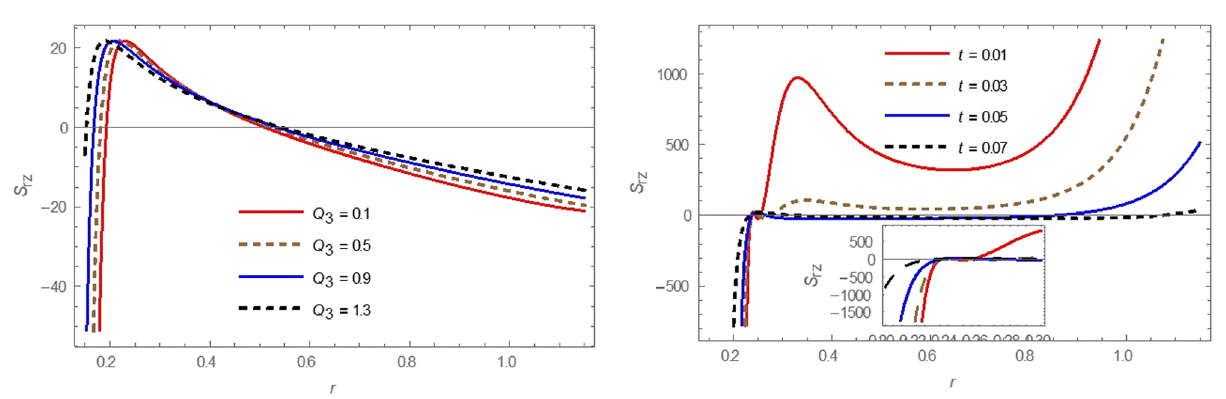
Figure 13: E ff ect of di ff erent values of Q 3 on stress with W